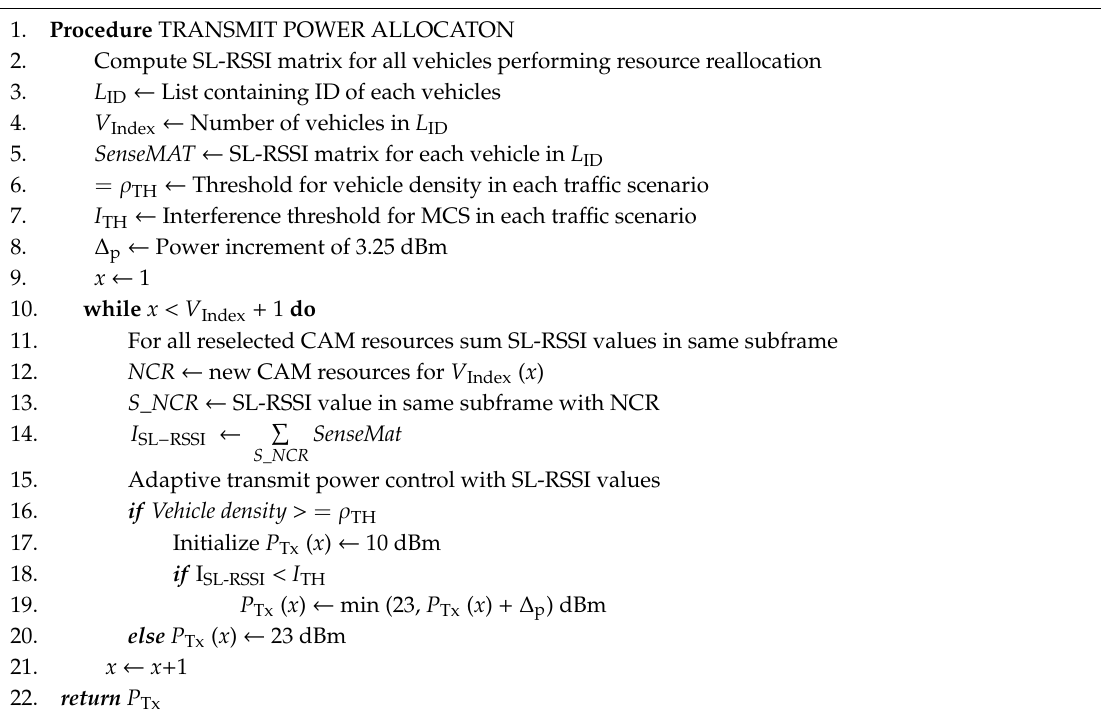
Algorithm 1: Pseudo-code for the Proposed A-TPC Algorithm